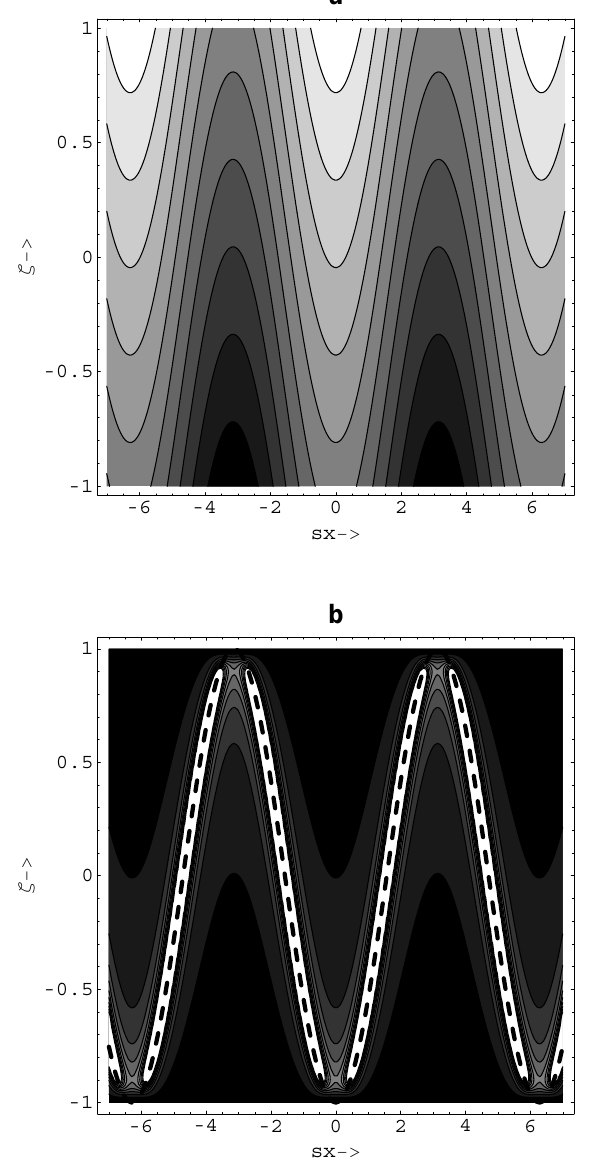
Fig. 7. (a) Depicts the contours of the plasma density perturbations Fig. 7 in the vicinity of the UHR in the x − ζ plane (lighter shading indi- cates higher values). (b) Illustrates the corresponding contour plot of the total electric field, together with the UHR contour (dashed).